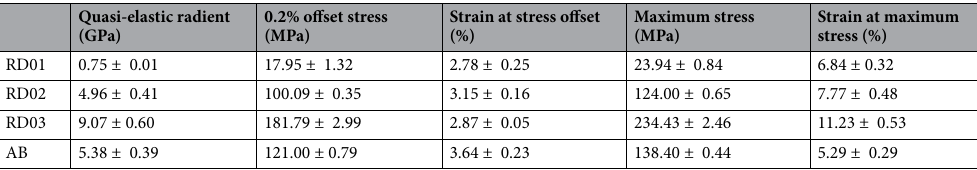
Table 2. Experimental values of tested FCCm lattice structures.